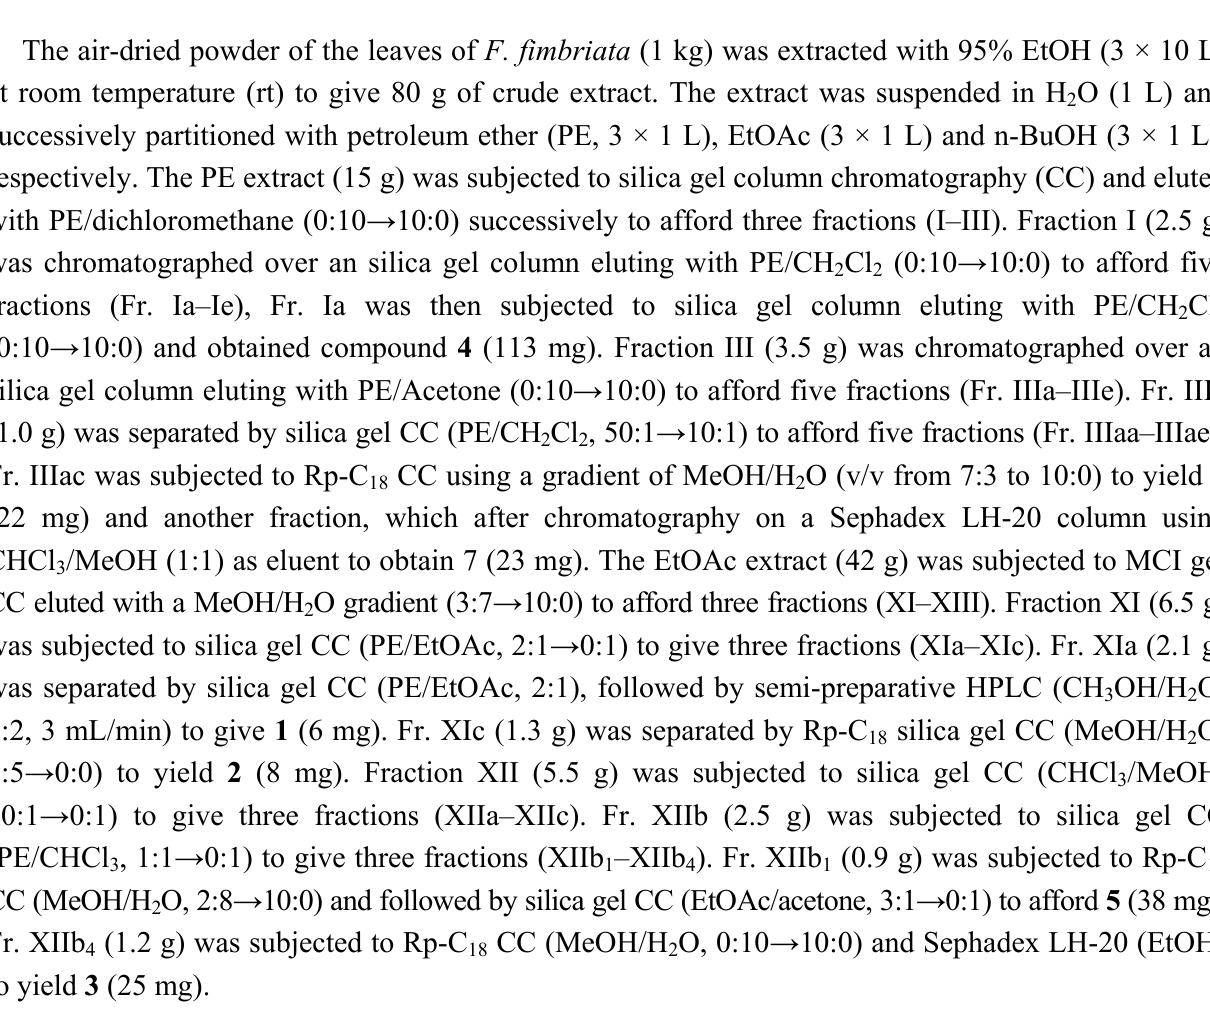
Table 1; positive ESIMS m / z 315.3 [M + Na] + , 607.6 [2M + Na] + ; HREIMS m / z 315.1943 [M + Na] + (calcd for C H O Na, 18 8 3